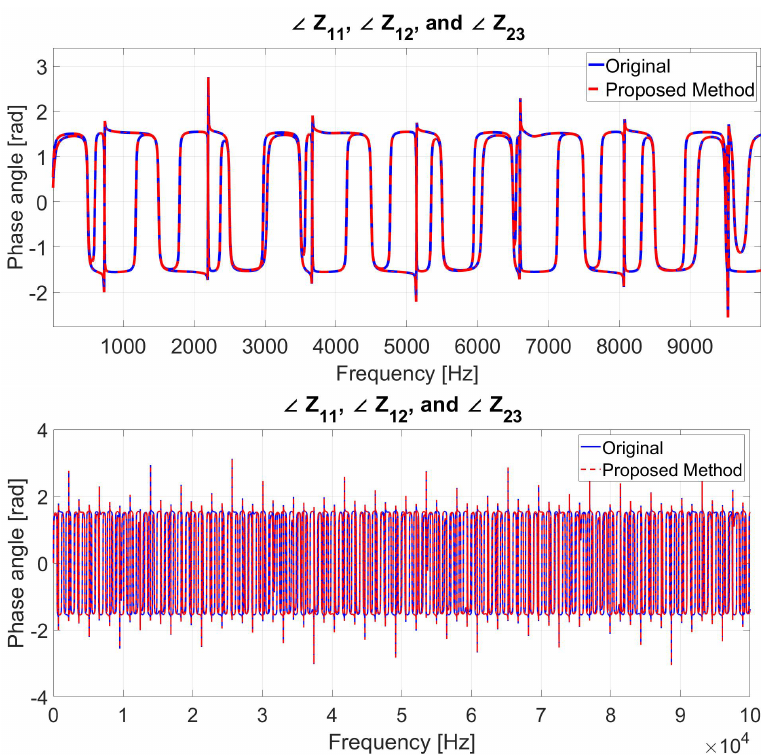
Figure 22. The Angle of the measured and fitted impedance using the proposed model, ∠ Z 11 , ∠ Z 12 , and ∠ Z 23